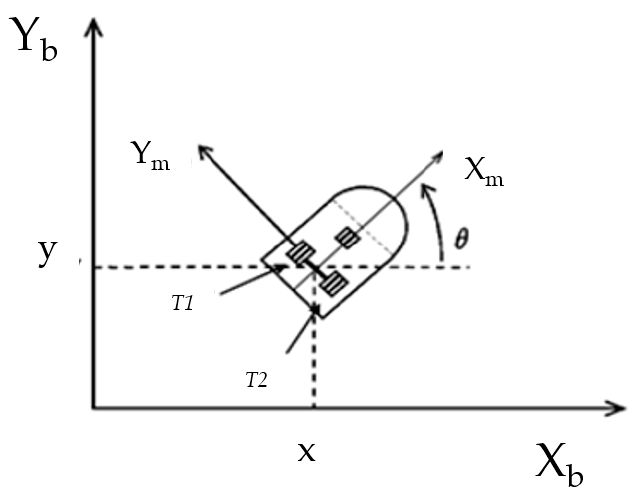
Figure 8. Mobile robot model.